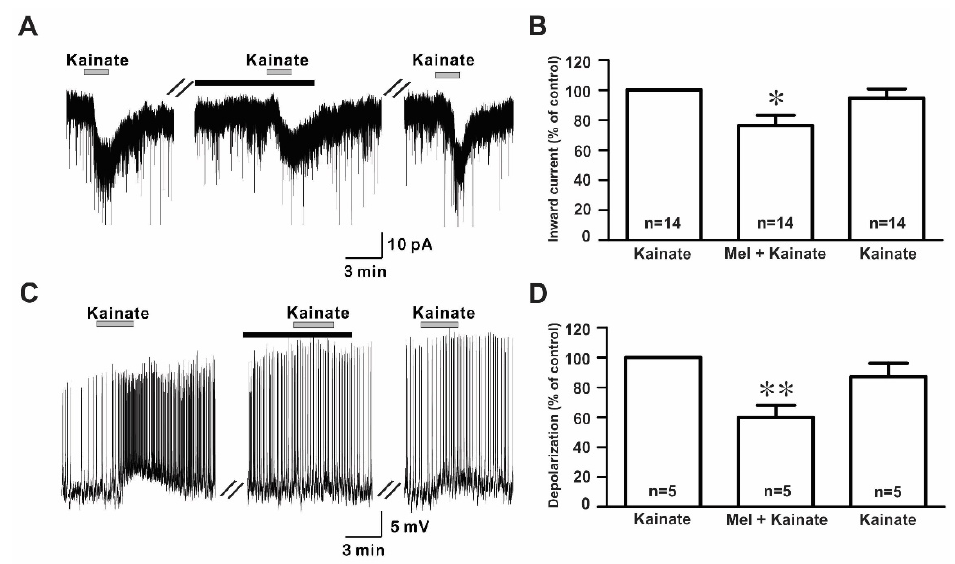
Figure 4. Effects of melatonin on kainate-induced responses. ( A ) A representative trace showing inward currents induced by kainate (10 μM) in the absence and the presence of 10 μM melatonin. The black bar represents the duration of the melatonin application. ( B ) Bar graph showing the mean relative percentage of inward currents induced by kainate in the presence of 10 μM melatonin and after washout of melatonin compared to kainate alone (* p < 0.05; one-way ANOVA). ( C ) A membrane potential trace showing membrane depolarization induced by kainate (10 μM) in the absence and the presence of 10 μM melatonin in the gramicidin-perforated current clamp mode. The black bar represents the duration of the melatonin application. ( D ) Bar graph showing the relative percentage of mean depolarizations induced by kainate in the presence of 10 μM melatonin and after melatonin washout compared to kainate alone (* p < 0.05, ** p < 0.01; one-way ANOVA). n , the number of neurons tested; Mel, melatonin.